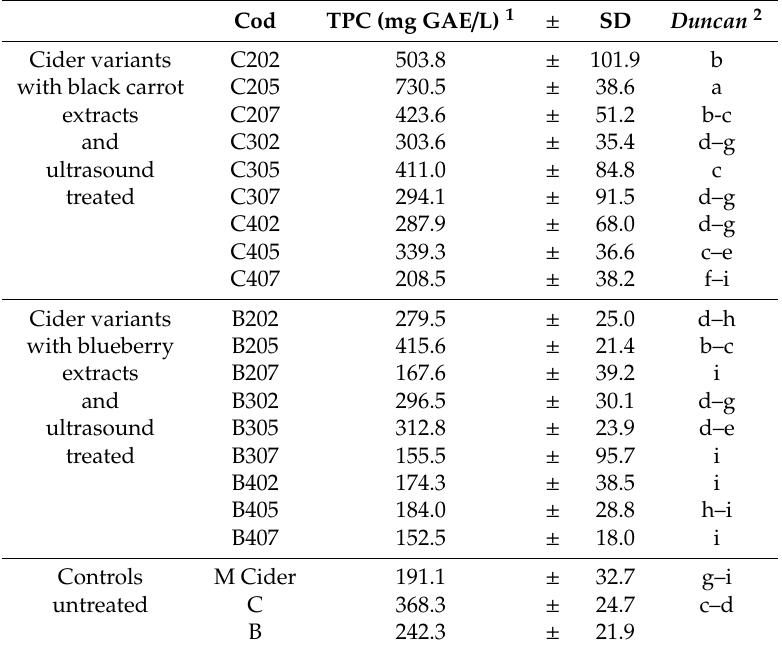
Table 2. Phenolic content of the cider experimental